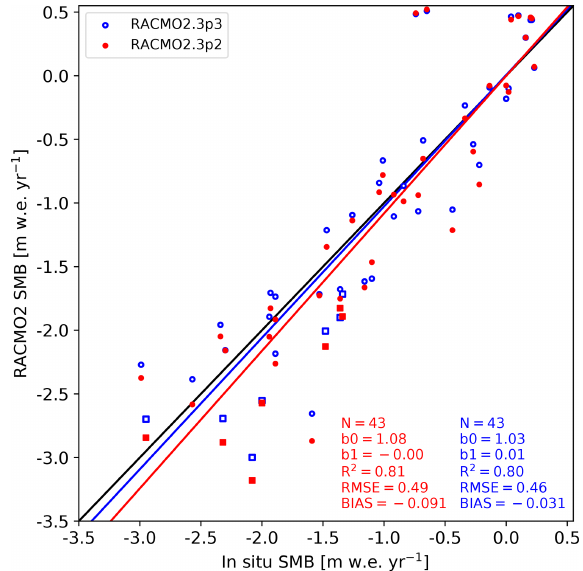
Figure 11. Surface mass balance along the K-transect in Rp3 (blue) and Rp2 (red), compared to annual in situ stake observations (mw.e.yr − 1 ). Measurements are taken between 2006 and 2015, with each dot representing 1 year. Only observations at least two grid points away from the ice margin in the RACMO2 grid are se- lected for evaluation (locations are shown in Fig. 8b). The black line is the one-to-one line, and the red and blue line show the lin- ear regression of the data, with b0 the slope and b1 the intercept. Number of records ( N ), determination coefficient ( R 2 ), root-mean- square error (RMSE, in mw.e.yr − 1 ), and bias (in mw.e.yr − 1 ) are also displayed. Results for S6 are shown with